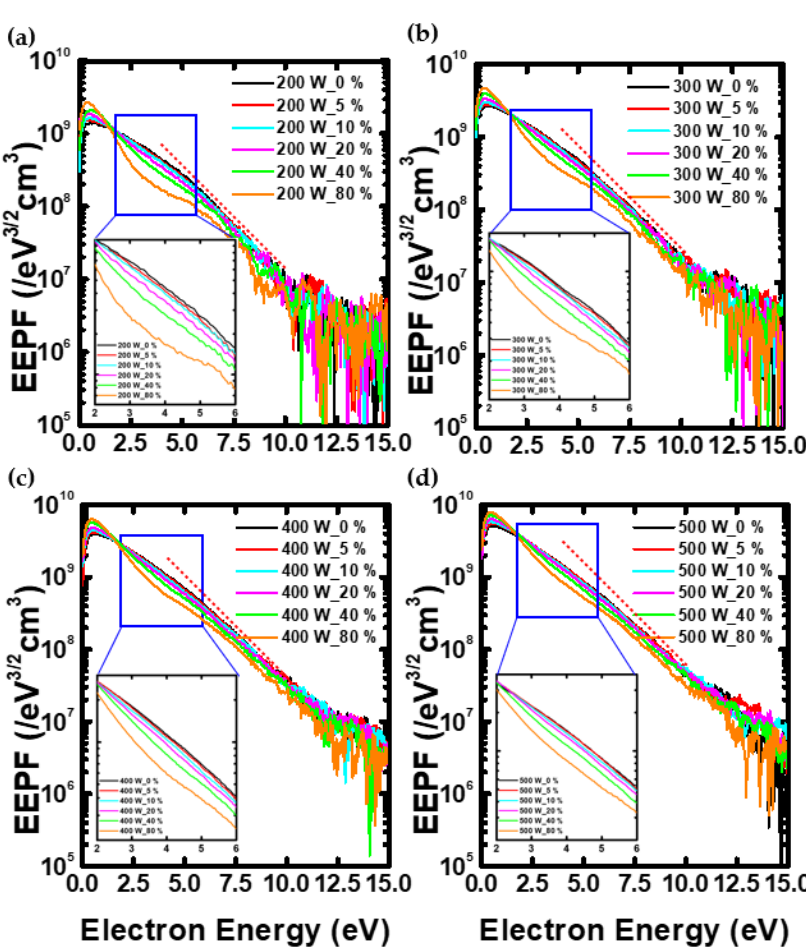
Figure 5. This is the EEPF measured using the Langmuir probe at ( a ) 200 W, ( b ) 300 W, ( c ) 400 W, and ( d ) 500 W.